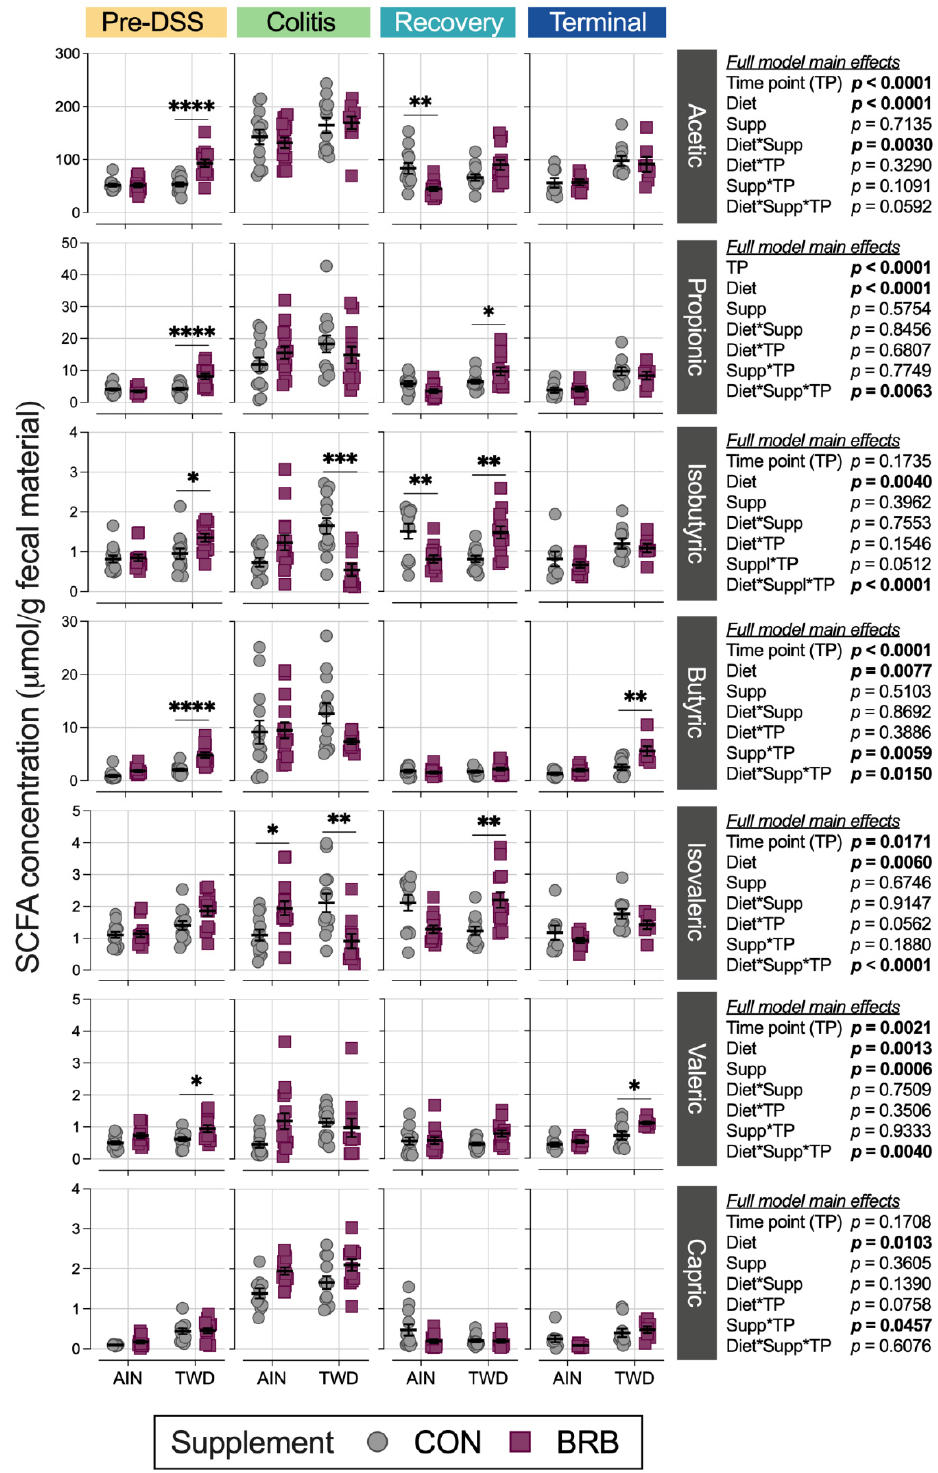
Figure 15. Short-chain fatty acid concentrations in fecal samples from mice fed CON or BRB-supplemented diets at each experimental time point (experiment B). Data are shown as individual values that represent each cage (as the biological unit) with mean ± SE. For simplified visualization, this plot shows only the statistical results as FDR-corrected p -values for comparisons between CON and BRB-supplemented diets, as indicated: *, p < 0.05; **, p < 0.01; ***, p < 0.001; and ****, p < 0.0001, as outlined in Materials and Methods. Complete results of all statistical analyses, including pairwise comparisons by basal diet and across time points, are provided in Tables S5–S7.